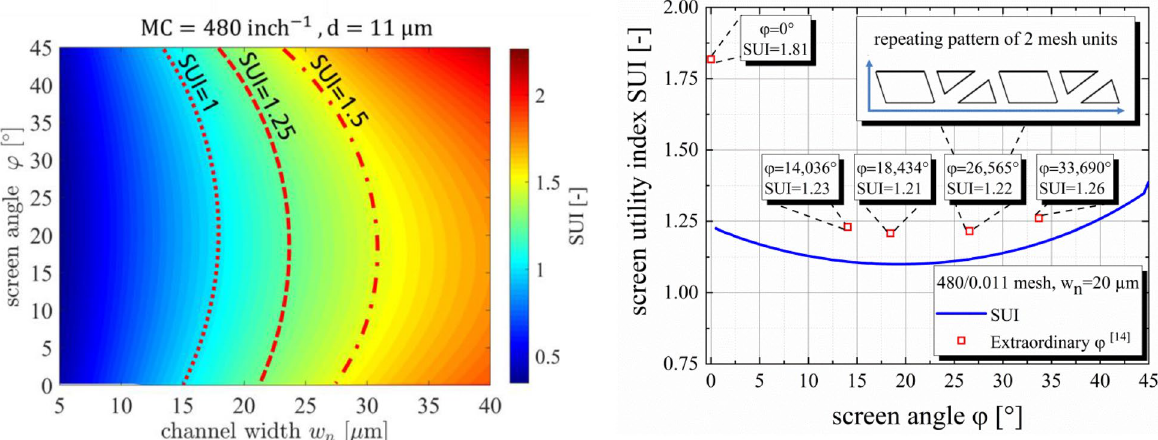
Figure 8. On the left, the screen utility index is simulated for all possible screen angles—screen opening width w n combinations between 0° < φ < 45° and 5 µm < w n < 40 µm. The underlying mesh is kept constant with a MC = 480 1/inch and d = 11 µm. The constant SUI lines for SUI = 1, 1.25, 1.5 are highlighted in red, indicating the nonlinear dependency on the screen angle φ. For low screen angles, the nonlinear characteristic vanishes whereas for high angles close to 45° the dependency becomes the dominant influencing factor. On the right, the screen utility index for the 480/0.011 mesh is highlighted with the inclusion of extraordinary screen angles φ. In our previous publication we derived those angles by utilizing the Farey sequence, revealing a highly repetitive opening pattern 15 . If those angles are compared to the average angle dependency of the SUI, a significant increase can be observed.